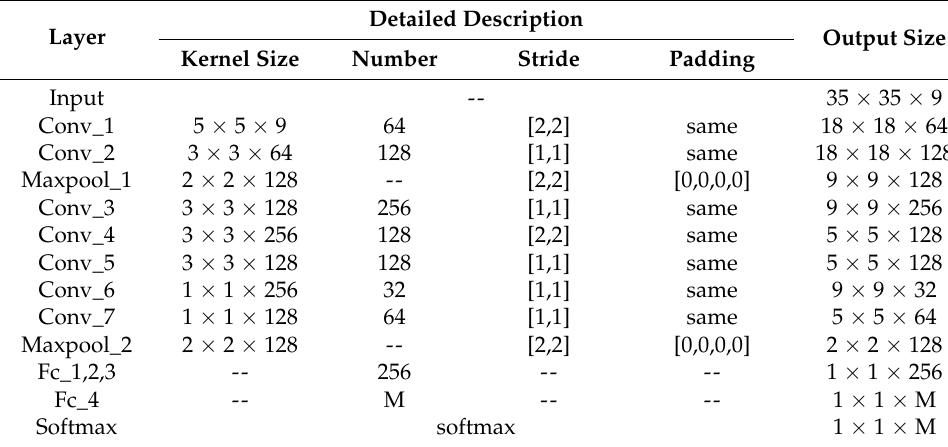
Table 2. Detailed configuration of MSCDN network architecture.